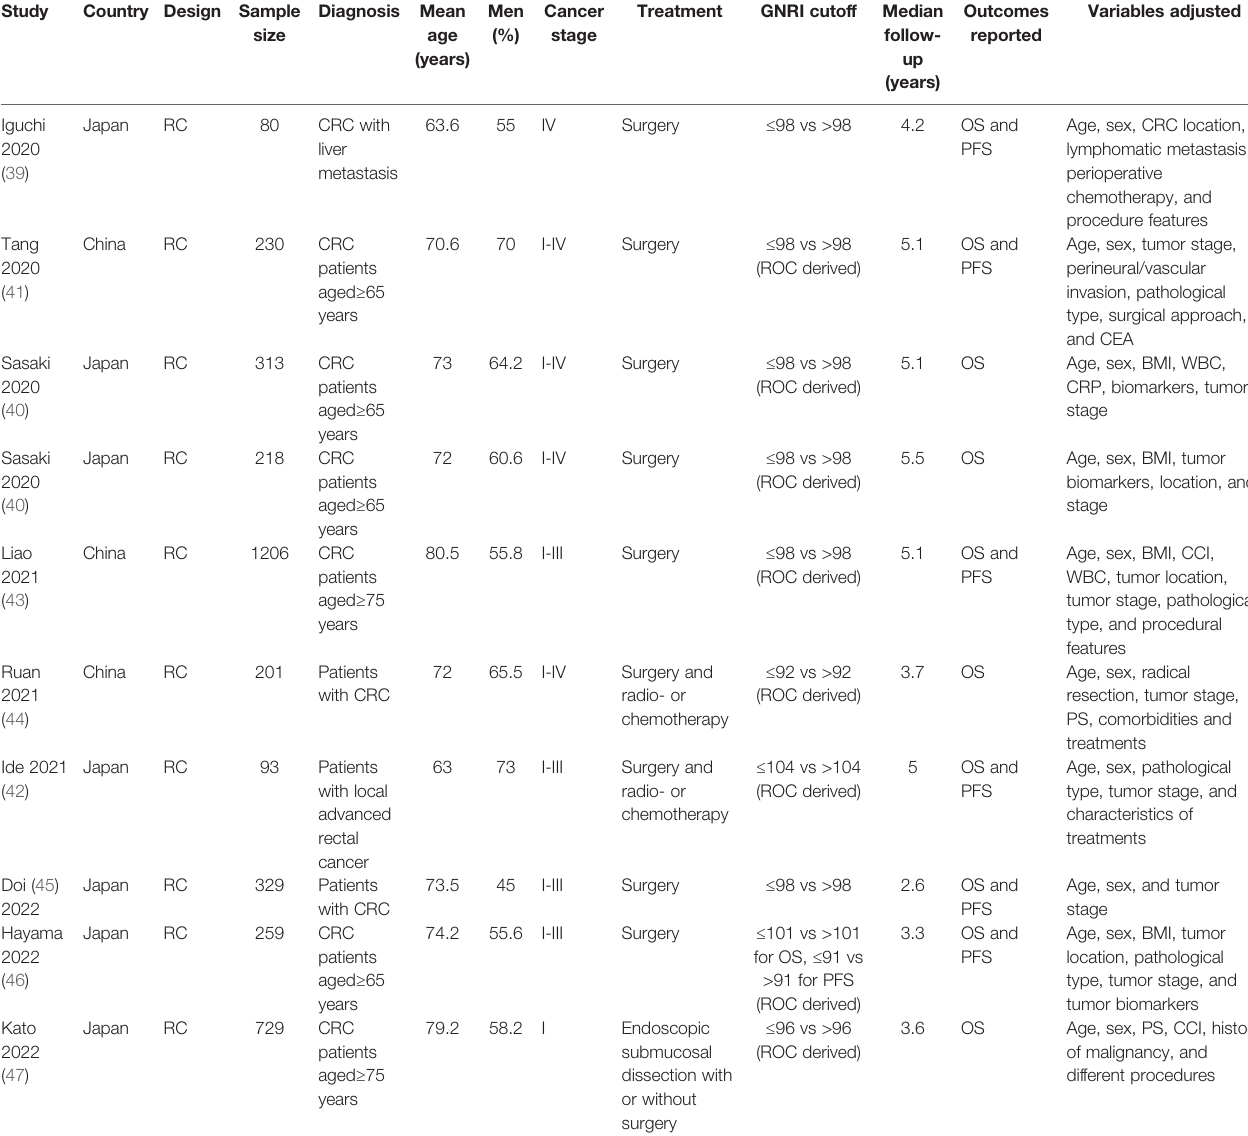
TABLE 1 | Characteristics of the included cohort